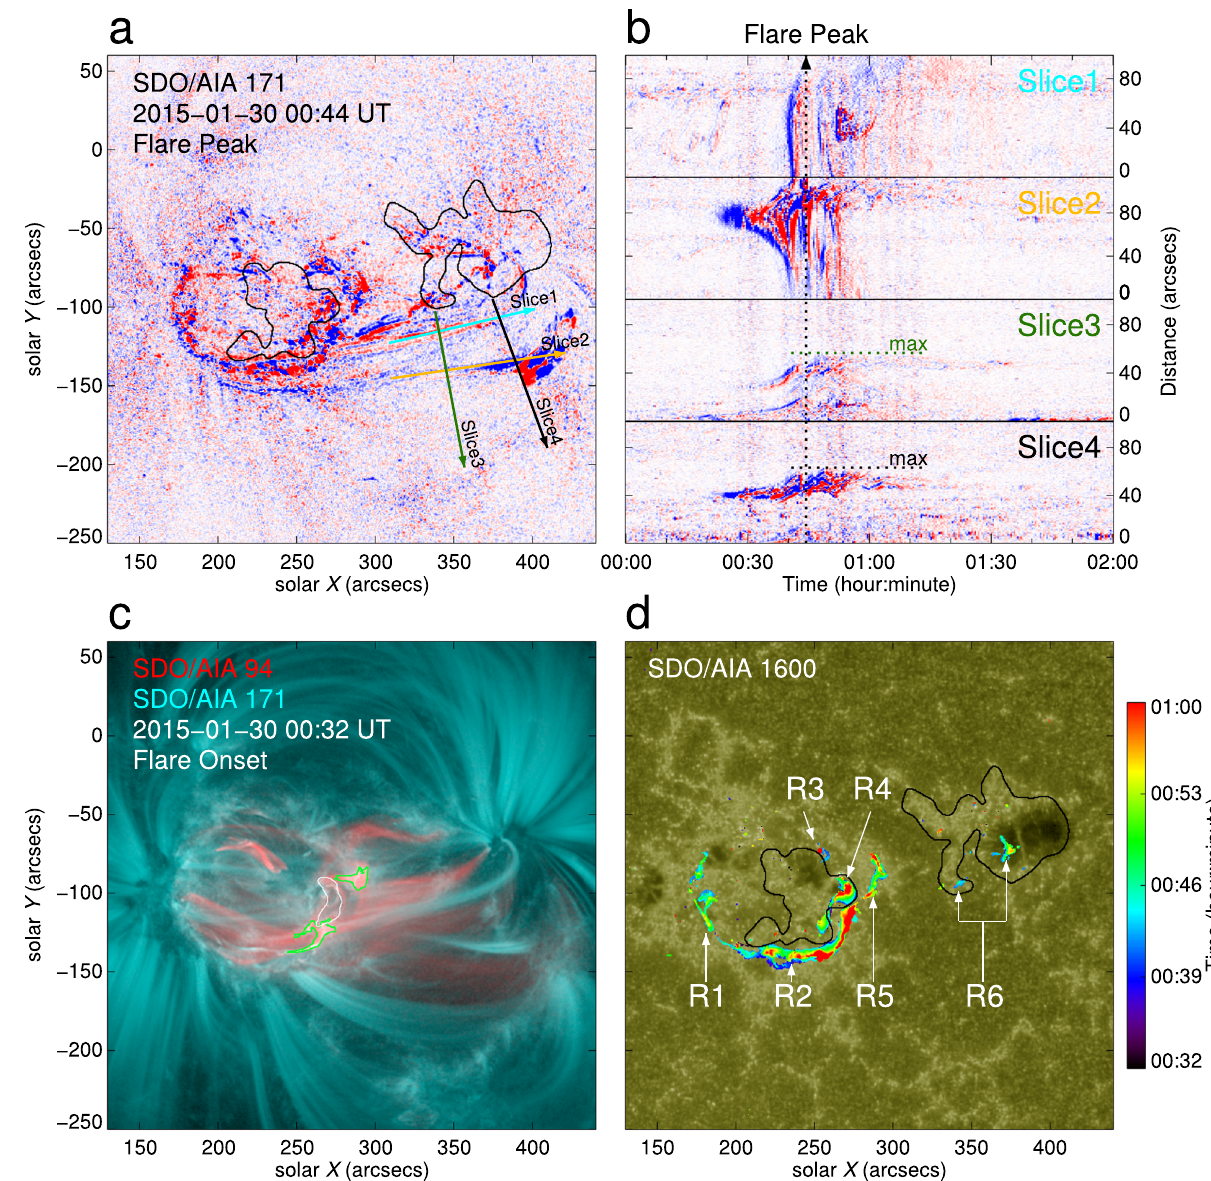
Fig. 3 Flare emission in AIA multiwavelength channels. a Running-difference image of AIA 171 Å showing the eruption structure at the peak time of the M2.0 fl are, 00:44 UT, on 30 January 2015. The red and blue colors represent positive and negative differences in intensity, respectively. The black contour in the background shows the positive polarity with B z being + 50 G. The cyan and orange lines show two different slices parallel to the coronal loop, while the green and black lines refer to the slices perpendicular to the coronal loop. b Time-distance diagrams showing the motion of the plasma along the four slices either parallel or perpendicular to the coronal loop. The black dotted line shows the fl are peak time at 00:44 UT. c Composite image of AIA 94 Å (red) and 171 Å (cyan) at the onset time of the M2.0 fl are, 00:32 UT, on 30 January 2015. The green and white contours represent 60% of the maximum emission at 94 Å and 50% of the maximum electric current integrated along the line of sight, respectively. d Timeseries of AIA 1600 Å emission starting from 00:32 UT. The black contour is the same as that in panel a . The arrows point to the fl are ribbons, which are labeled as R1 – Figure 4a – d exhibits the 3D dynamic evolution of the magnetic whole MFR then expands to a very large size, the spatial dis- fi eld and the electric current density at four typical moments tributions of four quantities, including the electric current, quasi- covering the main period of the event. First, the bifurcated part of separatrix layer, twist number, and magnetic fl ux, indicate that the MFR disappears when it rises initially. Subsequently, the the main body of the MFR is still complete and keeps its unbranched part of the MFR continues to rise and further coherence. It is noted that a current sheet is stretched out under reconnects with the sheared fi eld lines that surround it. During the MFR, which has been predicted in the standard solar fl are this process, several fi eld lines below the MFR become a part of model. Detailed dynamics of the MFR are shown in Supple- the MFR by magnetic reconnection. Their footpoints at one end, mentary Movie 1. We also measure the 3D height of the MFR originally located in the parasitic polarity P1, are gradually front and its velocity from the MHD simulation. As shown in transferred to the remote polarity P2. Meanwhile, the dome-like Fig. 5a, the MFR goes up at an almost constant velocity after its structure above is also stretched by the rising MFR. Although the initial acceleration, and it then decelerates gradually after the fl are